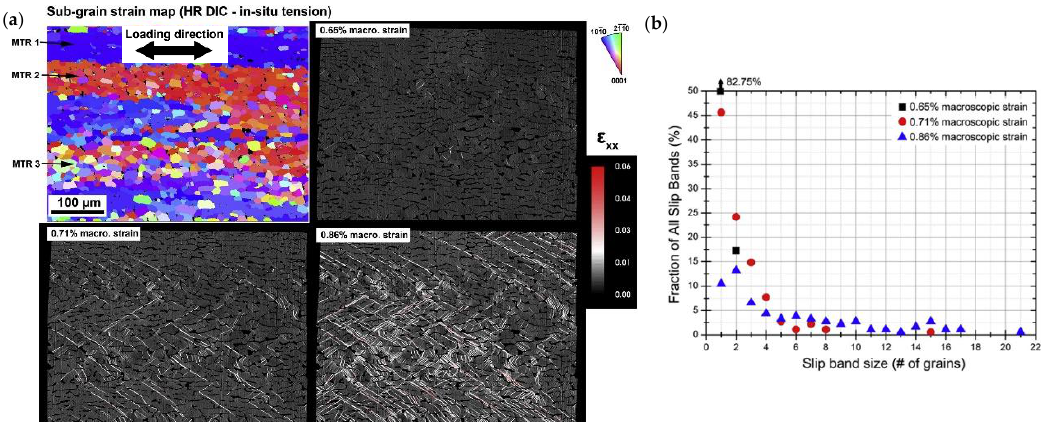
Figure 7. ( a ) Strain maps measured below macroscopic yielding using SEM-DIC are shown in relation to the microstructure and grain orientations (IPF map) measured using EBSD for 0.65%, 0.71% and 0.86% strain; ( b ) the fraction of total slip bands having localized slip band lengths measured using SEM-DIC [62].